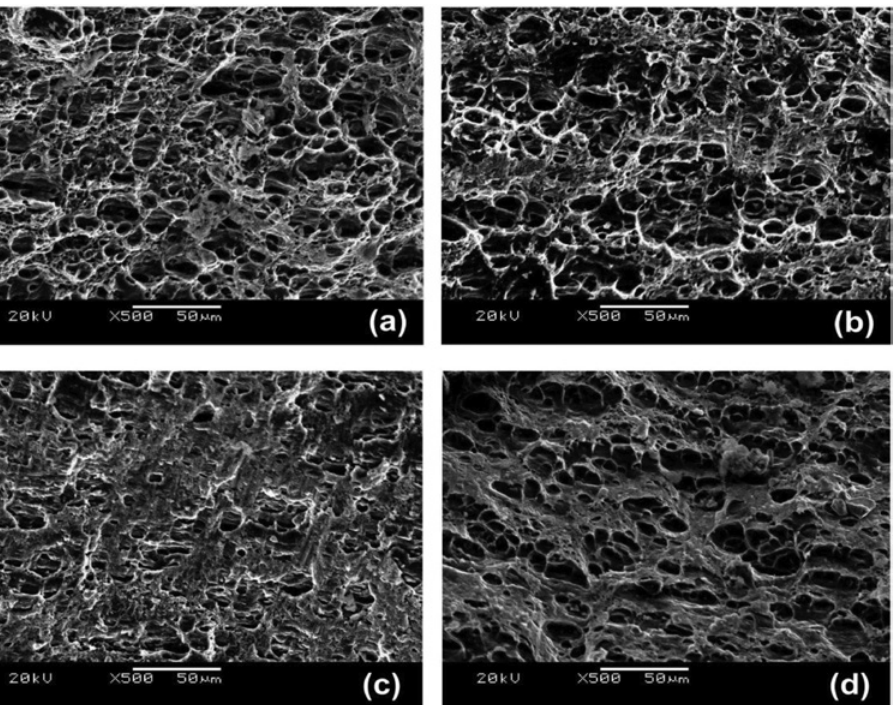
Figure 13: SEM images for the fracture surfaces in tensile tests: (a) 6082 side and (b) 6066 side without reinforcing material, (c) 6082 side and (d) 6066 side with reinforcing